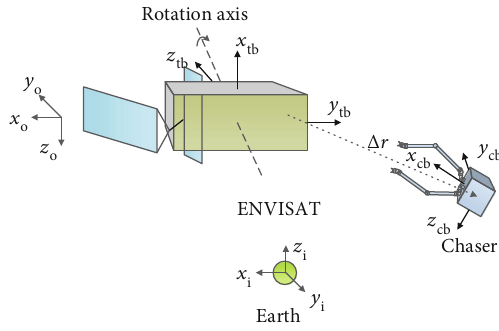
Figure 1: Schematic diagram of the approach and capture mission. The chaser spacecraft is equipped with two 7-DOF